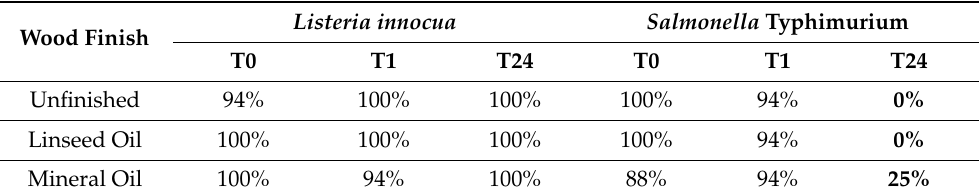
Table 1. Recovery (percentage of samples) of Listeria innocua or Salmonella Typhimurium from inoculated wood samples treated with different surface treatments after 0 (T0), 1 (T1) or 24 h at ambient temperature. Individual wood samples of four species (European beech, sugar maple, red oak, and white oak) were inoculated with 2 log CFU/wood sample (n = 4/species/treatment). Percentage indicates the number of wood samples in which the inoculated organism was detected at a specific time point (>1 colony per sample; n = 16). Percentages in bold typeface indicate a significant reduction ( p -value < 0.05) in the number of samples with recoverable Listeria innocua or Salmonella Typhimurium between the control (unfinished wood, T0) and the